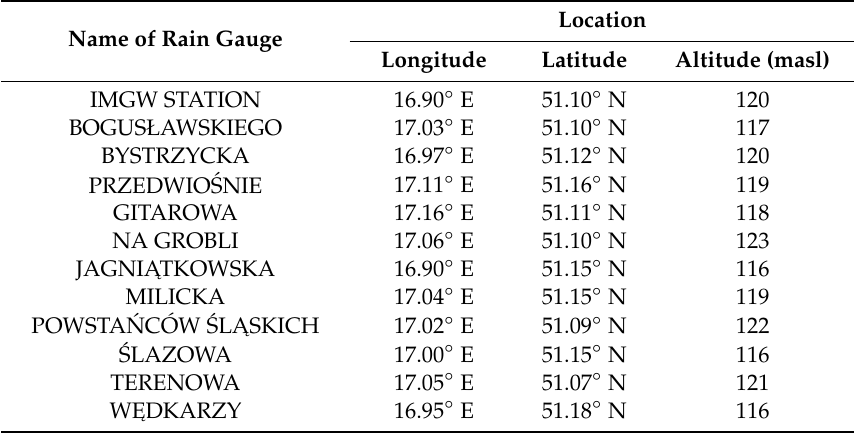
Figure 1. Location of measuring stations in Wrocław (red—Polish Institute of Meteorology and Water Management (IMGW) station; blue—Municipal Water and Sewage Company (MPWiK) stations—rain gauges and weather stations). Table 1. Location of rainfall measuring stations in Wroc ł aw.